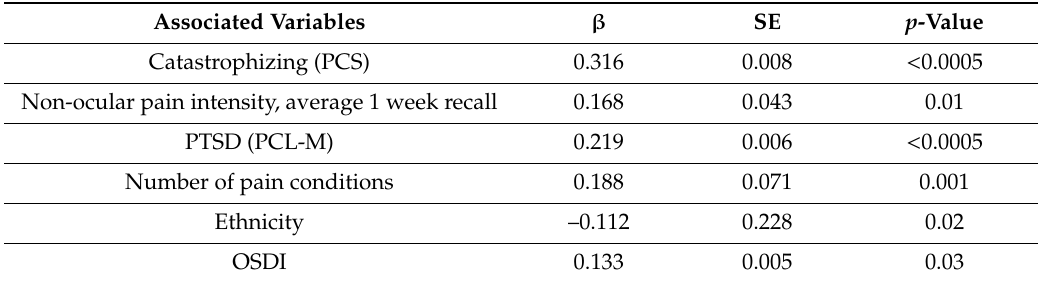
Table 2. Model of Variables that Impact Pain Interference (MPI-Interference). Associated